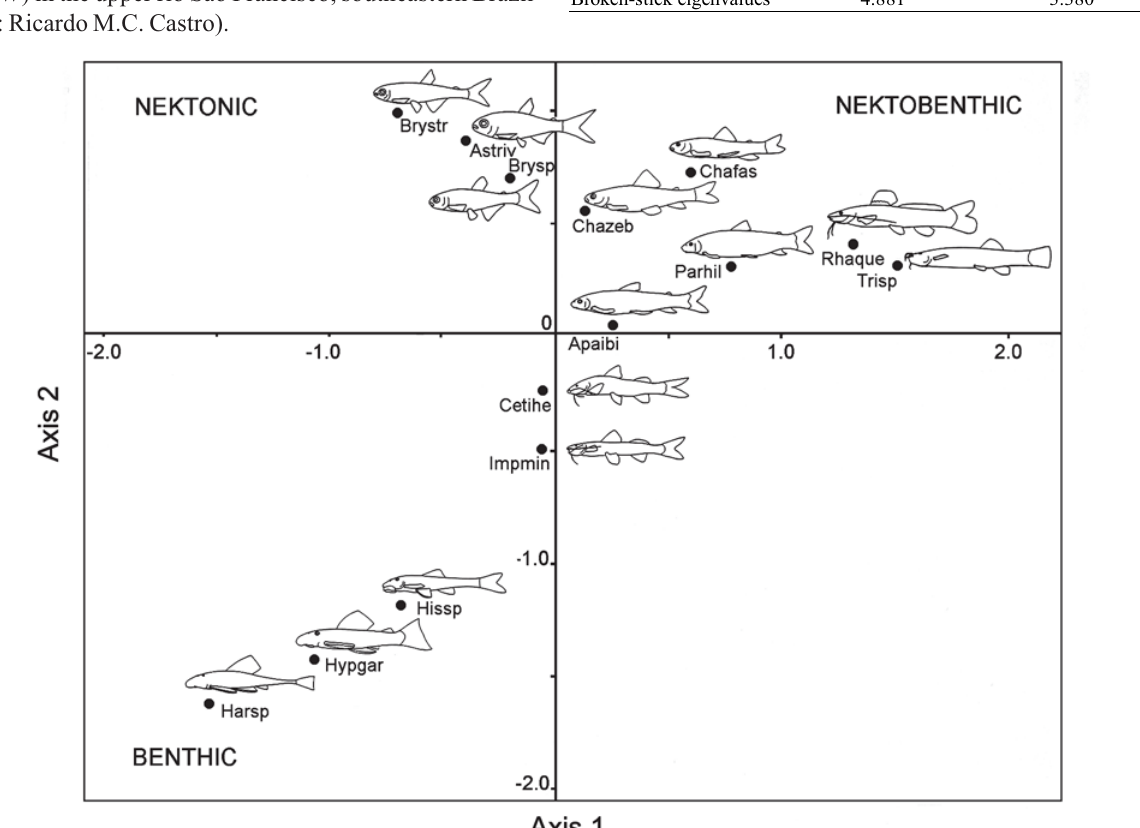
Fig. 2. Projection of the two first principal components of the 14 resident fish species in the upper rio São Francisco studied riffles, southeastern Brazil: Astriv, Astyanax rivularis ; Brystr, Bryconamericus stramineus ; Brysp, Bryconamericus sp.; Chafas, Characidium fasciatum ; Chazeb, Characidium zebra ; Apaibi, Apareiodon ibitiensis ; Parhil, Parodon hilarii ; Cetihe, Cetopsorhamdia iheringi ; Impmin, Imparfinis minutus ; Rhaque, Rhamdia quelen ; Trisp, Trichomycterus sp.; Hissp, Hisonotus sp.; Hypgar, Hypostomus garmani ; Harsp, Harttia sp.